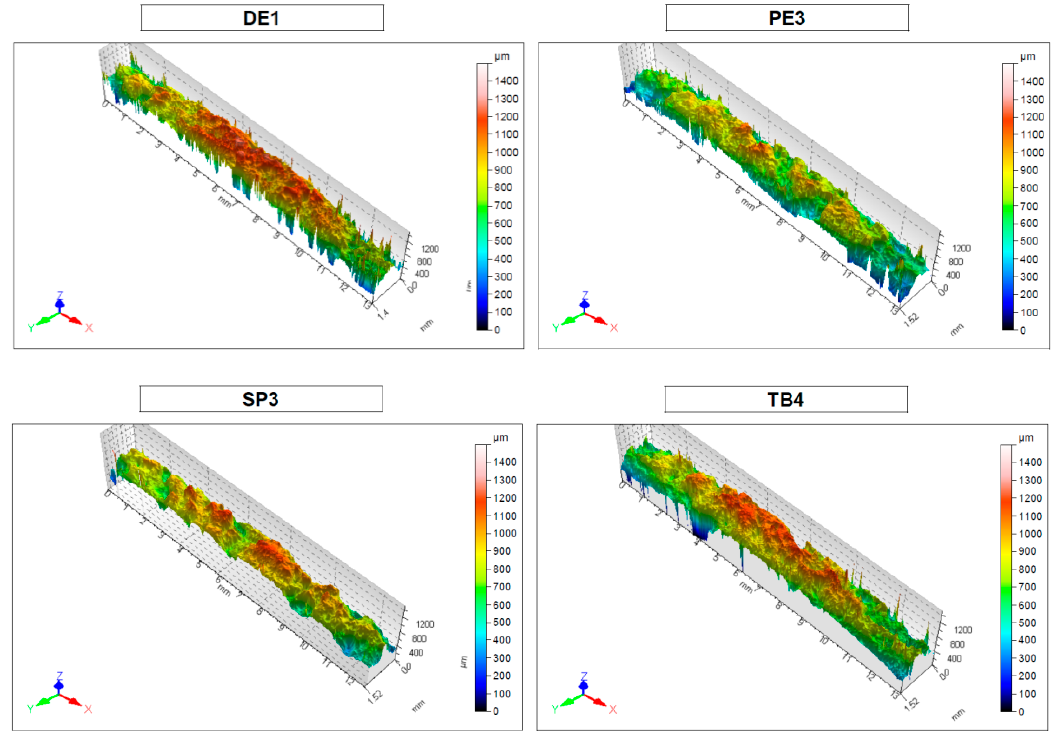
Figure 3. 3D topography of the worn surface of DE1, PE3, SP3, and TB4 discs.